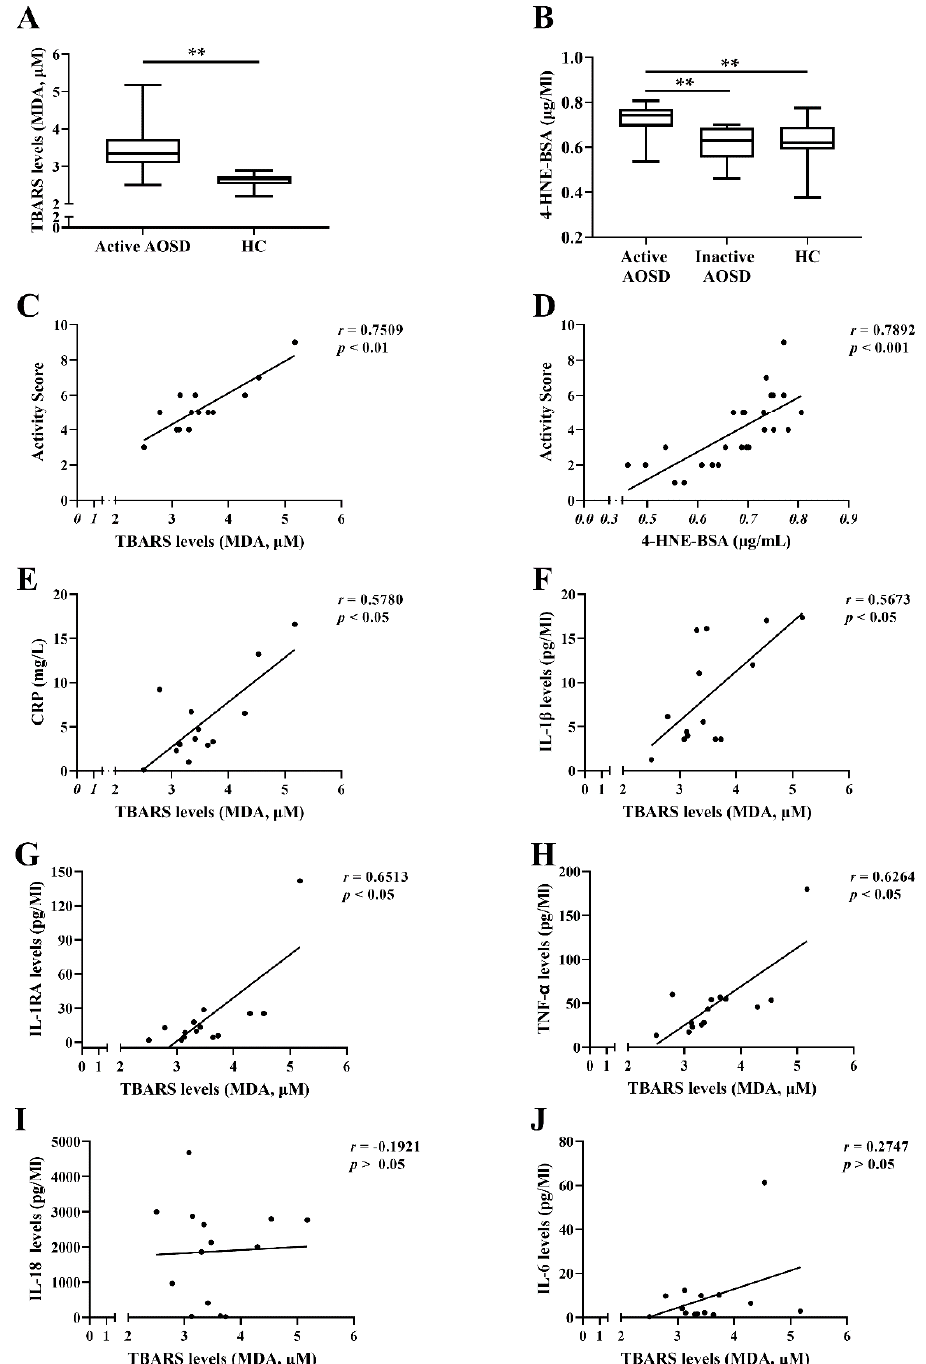
Figure 4. Plasma levels of LPO-related metabolites and their relation to disease activity and inflammatory parameters in AOSD patients. ( A ) Comparison of plasma MDA (malondialdehyde) levels between active AOSD patients ( n = 14) and HC subjects ( n = 9). ( B ) Comparison of plasma 4-hydroxyalkenals (4-HNE) levels among active AOSD patients ( n = 14), inactive AOSD patients ( n = 11), and HC subjects ( n = 9). The correlation of plasma levels of ( C ) MDA or ( D ) 4-HNE with disease activity scores, or between MDA levels and ( E ) CRP, ( F ) IL-1 β , ( G ) IL-1RA, ( H ) TNF- α , ( I ) IL-18, or ( J ) IL-6. The p -values were determined by using the Kruskal–Wallis test. ** p -value < 0.01. The correlation of 4-HNE-BSA levels with activity scores ( D ). The correlation of MDA levels with ( C ) activity scores, ( E ) CRP, ( F ) IL-1 β , ( G ) IL-1RA, ( H ) TNF- α , ( I ) IL-18, or ( J ) IL-6. The p -values were determined by Spearman’s test. AOSD: adult-onset Still’s disease; CRP: C-reactive protein; HC: healthy controls; IL: interleukin; IL-1RA: interleukin-1 receptor antagonist; TNF: tumor necrosis factor.